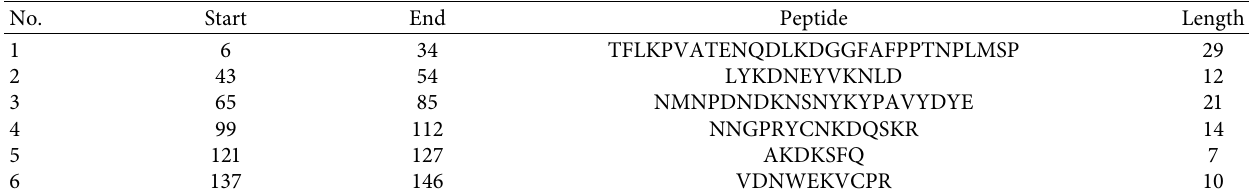
Table 4: Linear B-cell epitope prediction using the IEDB tool.